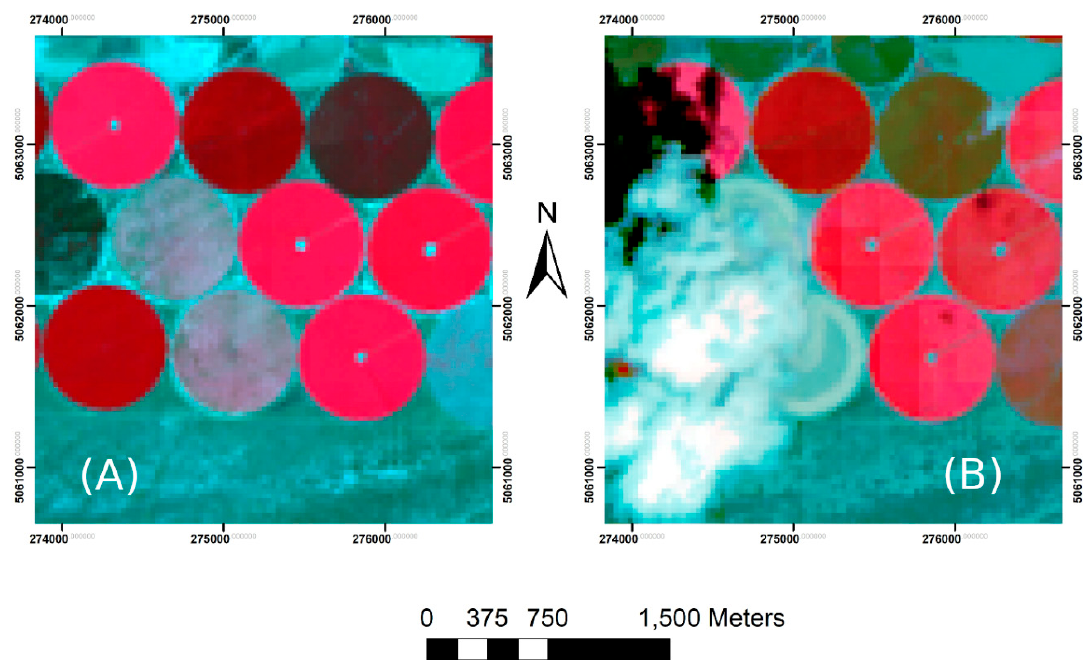
Figure 2. Color-infrared false-color composite of Landsat 8 OLI (path 044, row 028) reflectances acquired on ( A ) 8 July 2014 and ( B ) 24 July 2014. Because of the clouds and shadows in (B), only the southeast flight line was used for each aircraft altitude.